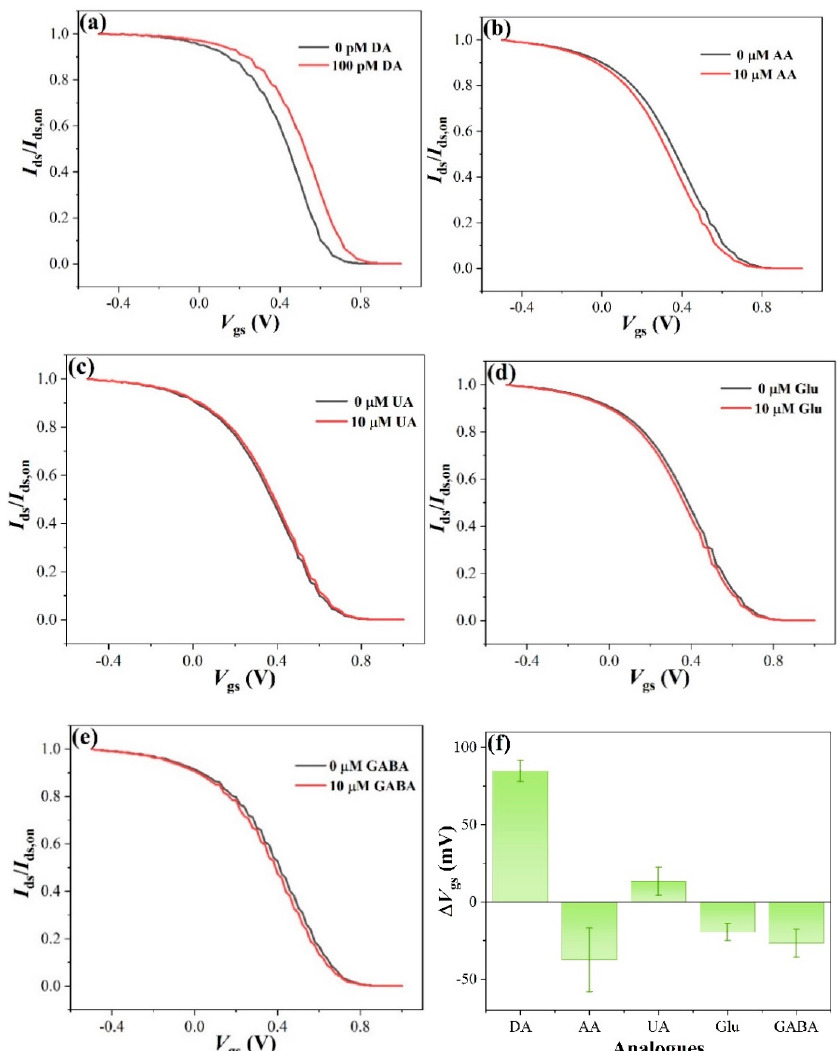
Figure 5. Transfer characteristics of the flexible iOECTs with ( a ) 100 pM dopamine (DA), 10 μ M ( b ) ascorbic acid (AA), ( c ) uric acid (UA), ( d ) glutamate (Glu), and ( e ) Gamma-aminobutyric acid (GABA). ( f ) Column comparison graph of the shifts in gate potential obtained from a – e .